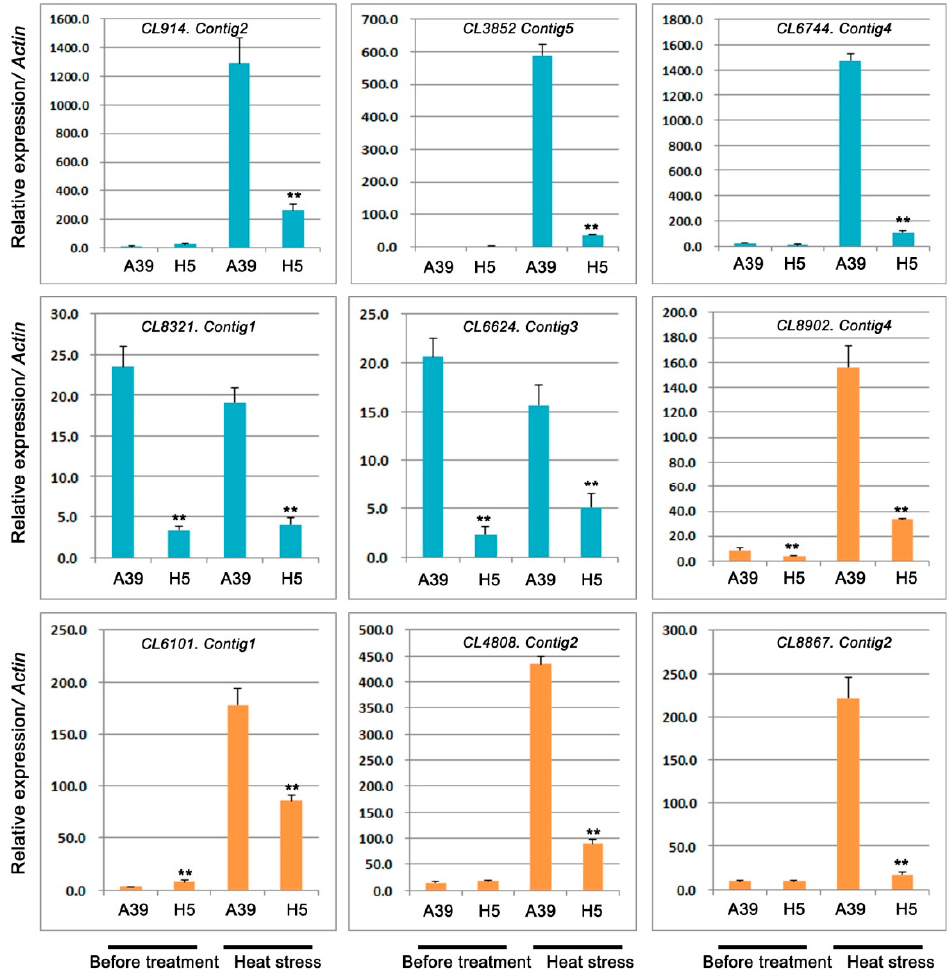
Figure 7. Relative expression of genes related to transcription factors (bHLHs, PCL1s, PIF1s) and pentatricopeptide repeat-containing protein. Data are presented as the mean ± standard deviation ( n = 9). ** p ≤ 0.01, Student’s t test.